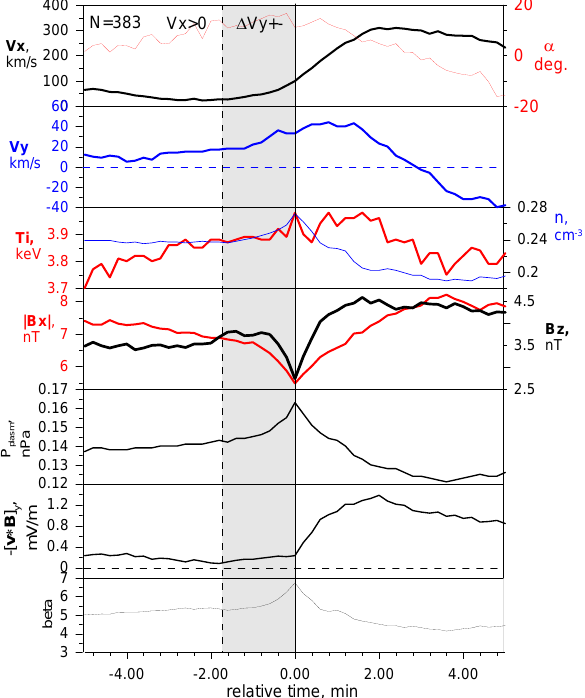
Fig. 8. (a) Histograms of the time delay of the maximal velocity deviation to dusk (top) and to dawn (bottom) relative to the time of BBFs’ front pass; (b) histograms of the maximal velocity deviation values: to dawn (left) and to dusk (right); (c) the scheme of the plasma motion (red vortexes) around BBF (blue oval) in the XY